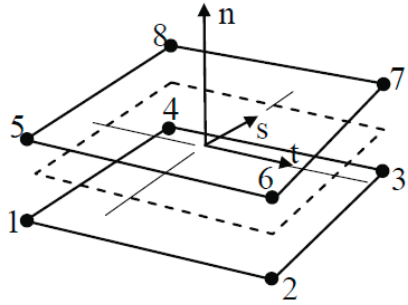
Figure 5. Eight-node 3D cohesive element [38].